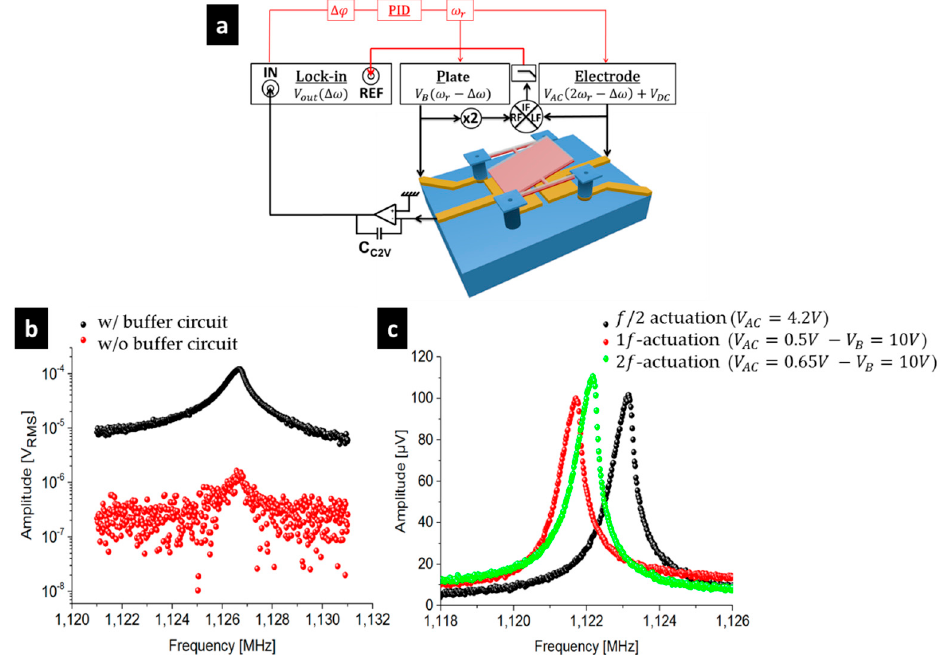
Figure 6. Enhancement provided by the buffer circuit: ( a ) Synopsis showing the set ‐ up to characterize the pixels in a down ‐ mixed readout scheme (in open loop or in a closed ‐ loop: red part); ( b ) Comparison of the output signal between a semitone down ‐ mixing approach with the buffer circuit and without the buffer circuit (the polarization voltages are explained in Table 2); ( c ) Typical output signals for the three down ‐ mixing approaches with the buffer circuit. At resonance, the capacitance variation is close to 10 aF. The SNR is larger than 40 dB for the three cases.